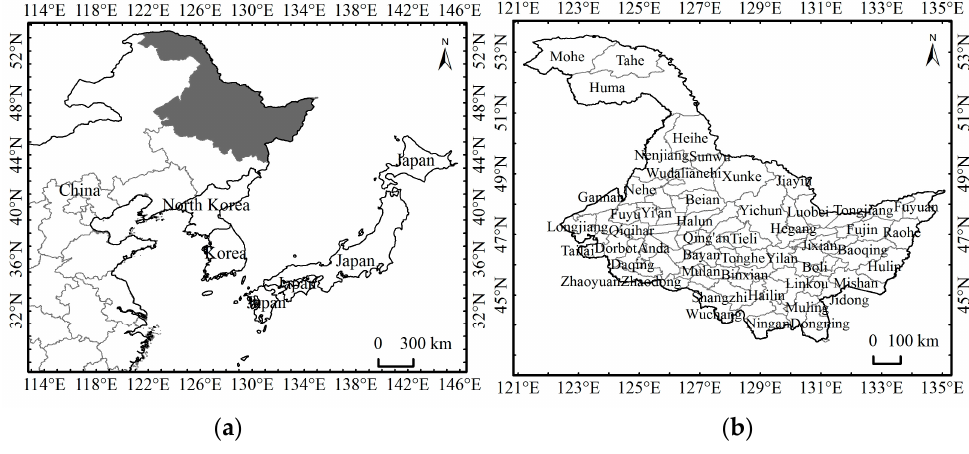
Figure 1. Maps to show the location of Heilongjiang Province within northeastern China ( a ) and its administrative subdivisions ( b ).